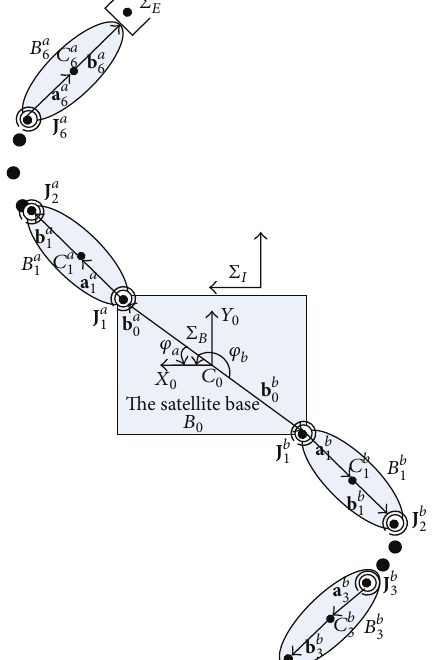
Figure 1: The model of the dual-arm space robotic